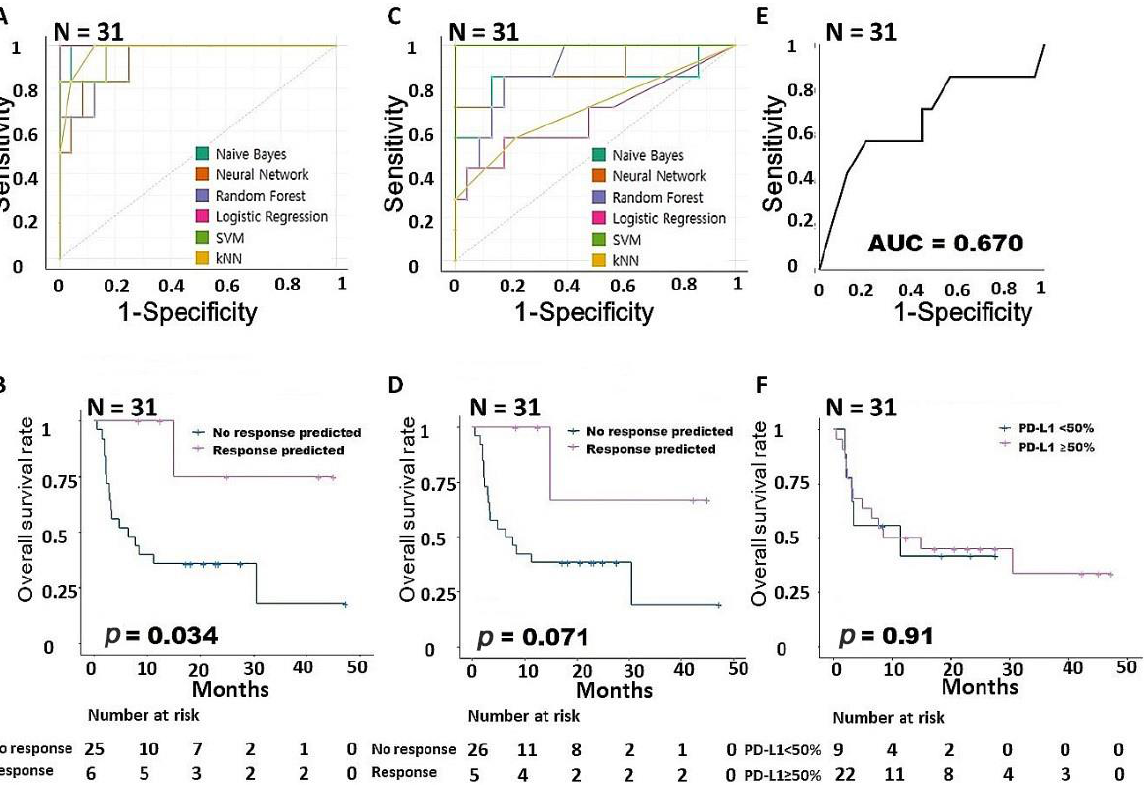
Figure 2. Building a predictive model for responsiveness to PD-1 inhibitors in LUAD. ( A ) Comparison of the AUCs for the intrinsic gene signature according to six machine learning models. ( B ) Survival analysis according to the intrinsic gene signature. ( C ) Comparison of the AUCs for the extrinsic gene signature according to six machine learning models. ( D ) Survival analysis according to the extrinsic gene signature. ( E ) AUC according to PD-L1 expression. ( F ) Survival analysis according to PD-L1 expression. AUC, area under the ROC curve; LUAD, lung adenocarcinoma; PD-1, programmed cell death protein 1; PD-L1, programmed cell death-ligand 1.